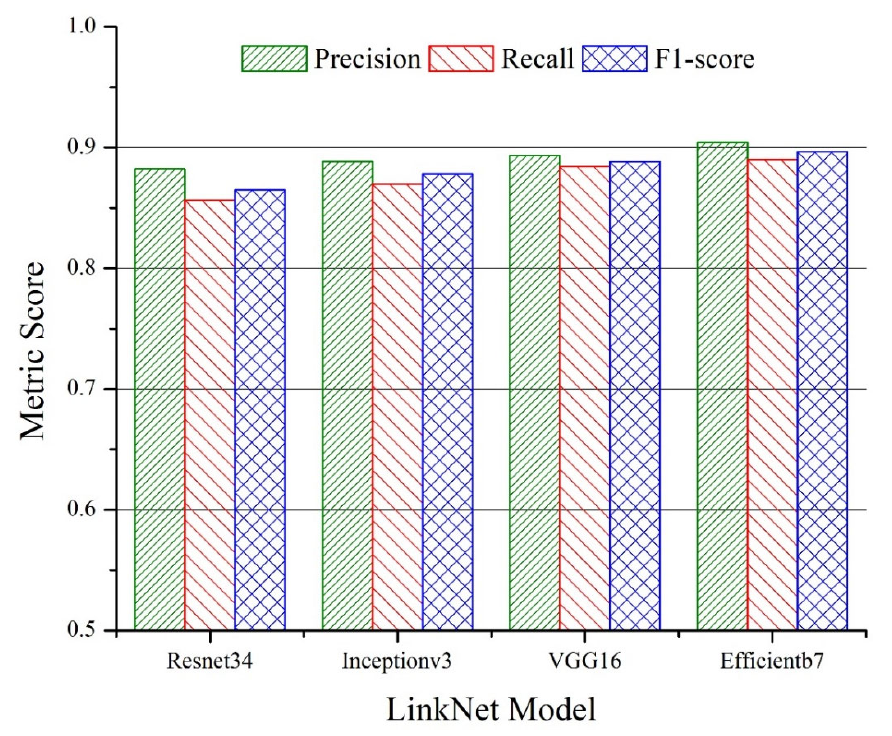
Figure 6. Average values of precision, recall and F1-score for LinkNet models with different backbones for test data.